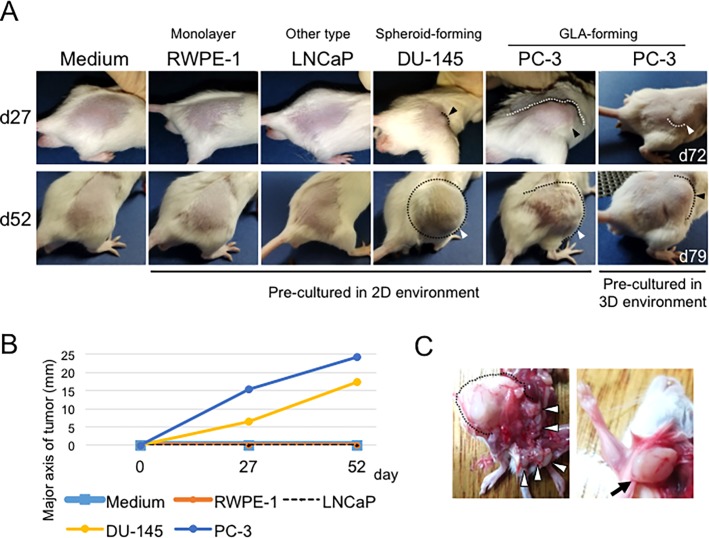
The difference in tumorigenicity and metastatic potentials between spheroid-forming and GLA-forming adenocarcinomas.(A) In vivo tumorigenicity of PC-3 (GLA-forming), DU-145 (spheroid-forming), LNCaP (other type of aggregates), and RWPE-1 (monolayer sheet-forming) cells. Each cell line was pre-cultured under the 2D conditions and transplanted to SCID mice. The PC-3 cells were pre-cultured in 2D or 3D conditions. The photographs on day 27, 52, 72, and 79 after the transplantation were shown. Arrows indicate tumors. Margins of tumors were traced with dotted lines. Tumor sizes were shown in Table 2. (B) Tumor growth of each cell line. (C) Primary tumor and lymph node metastasis of the PC-3 cells on day 52. The primary tumor was shown with dotted line. Metastasis was seen in the regional lymph nodes of the prostate (white arrows) and an axilla lymph node (arrow).